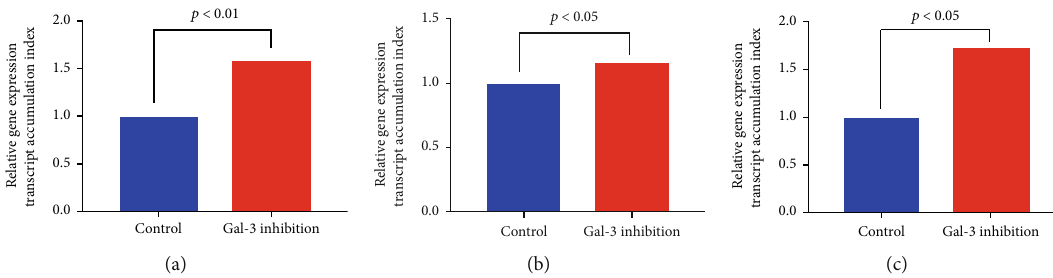
Figure 7: E ff ect of galectin-3 inhibition on gene expression of MUC5AC and MUC5B NF- κβ in lung epithelial cell line A549. A549 cells incubated with Gal-3 inhibitor (Ac-SDKP), and gene expression of MUC5AC and MUC5B and NF- κβ assessed using real-time qPCR. Comparative real-time qPCR analysis showing relative gene expression of MUC5AC and MUC5B and NF- κβ in A549 cells. Data normalized to the housekeeping gene β -actin and untreated cells were used as control. Gene expression was calculated using the comparative CT method. Results are expressed as the mean ± SD , n = 3 separate